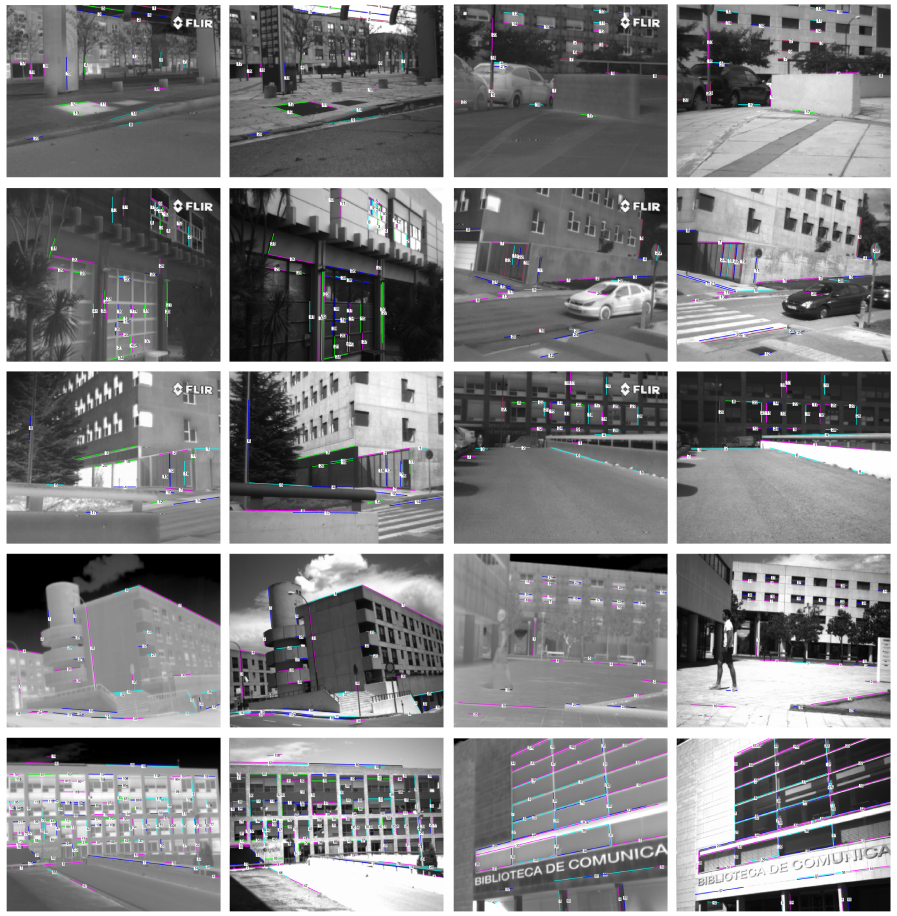
Figure 9. Demonstration of matching results of the PC-MLH (different colours mean that the matched lines are detected from different local homography layers). The images in the 1st and 3rd columns belong to LWIR images, and those in the 2nd and 4th columns are VS ones. Table 2. Performance comparison among different